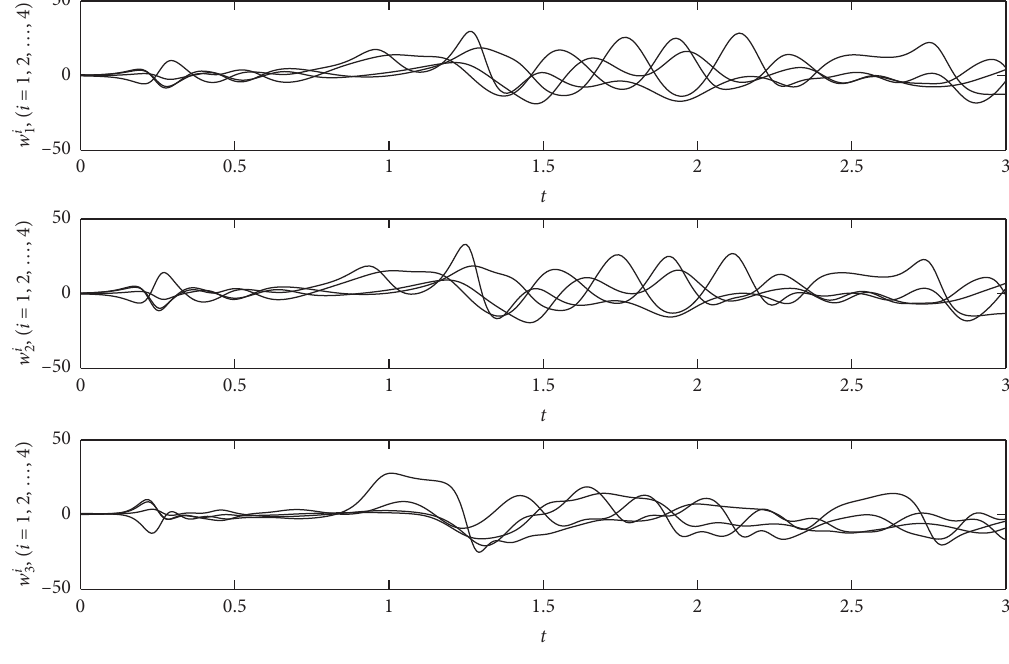
Figure 1: Error evolution of two networks.